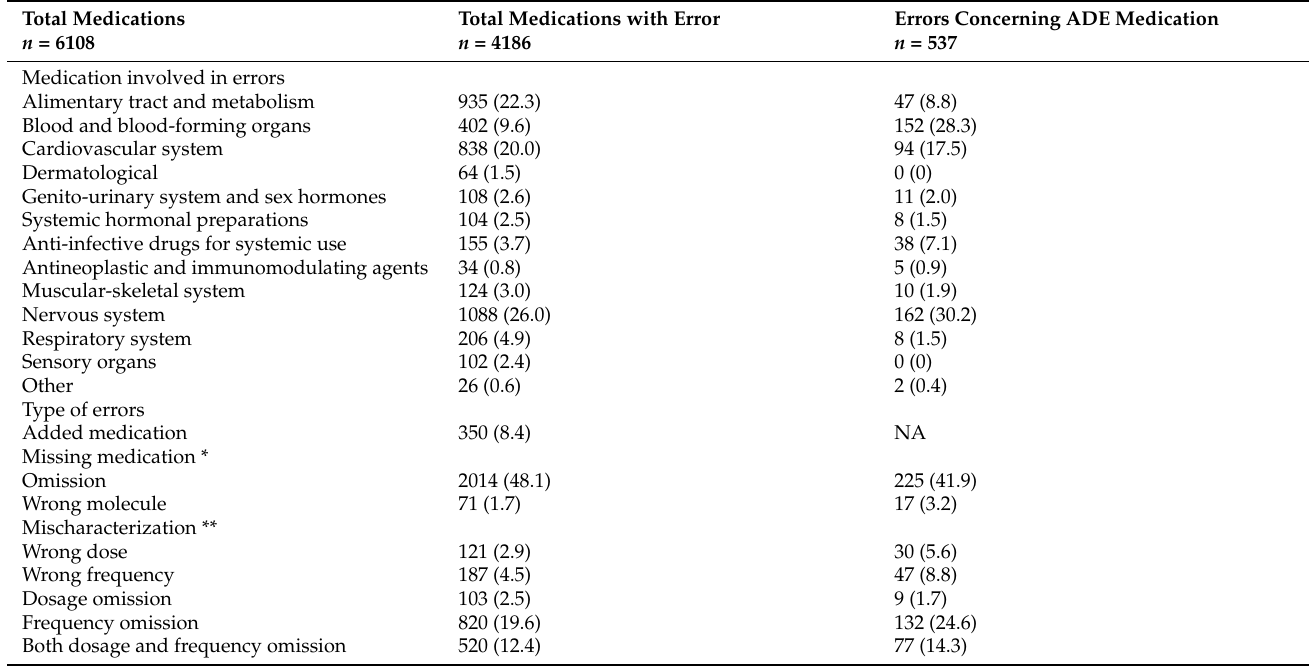
Table 3. Characteristics of errors on physician medication lists.